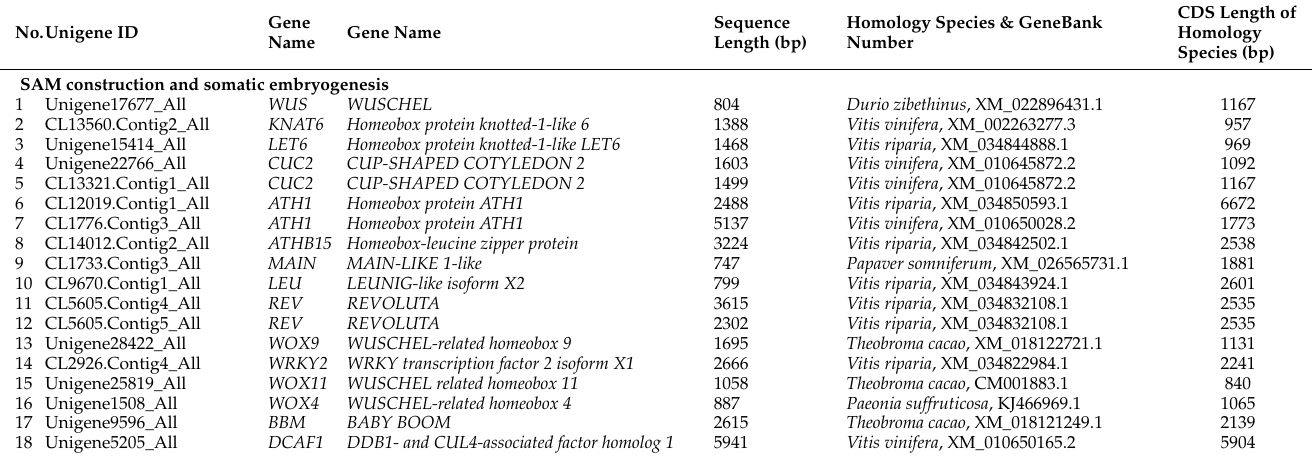
Figure 4. The number of DEGs in 10 groups and KEGG and GO enrichment analysis of the DEGs in S1-vs.-S3. ( a ) Number of DEGs in 10 groups. ( b ) Venn diagram showing overlap between S1-vs.-S2 and S1-vs.-S3. ( c ) The number of up-regulated and down-regulated DEGs in S1-vs.-S2 and S1-vs.-S3. ( d ) KEGG enrichment of the up-regulated DEGs in S1-vs.-S3. ( e ) GO enrichment of the up-regulated DEGs in S1-vs.-S3. Table 3. Identification of the candidate genes annotated to somatic embryogenesis.